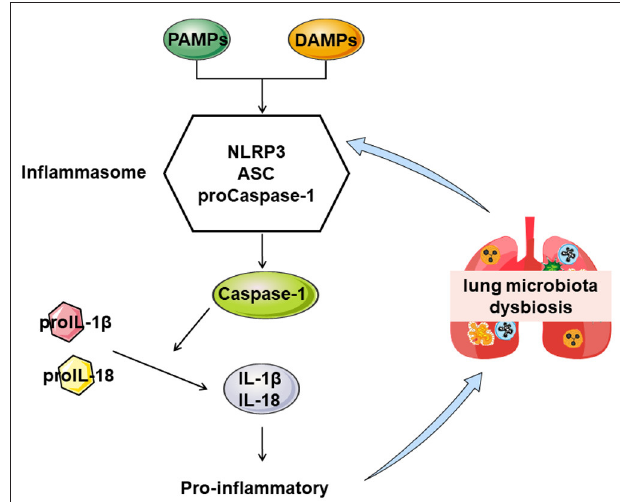
FIGURE 1 | The proposed mechanism by which YS treats COPD.